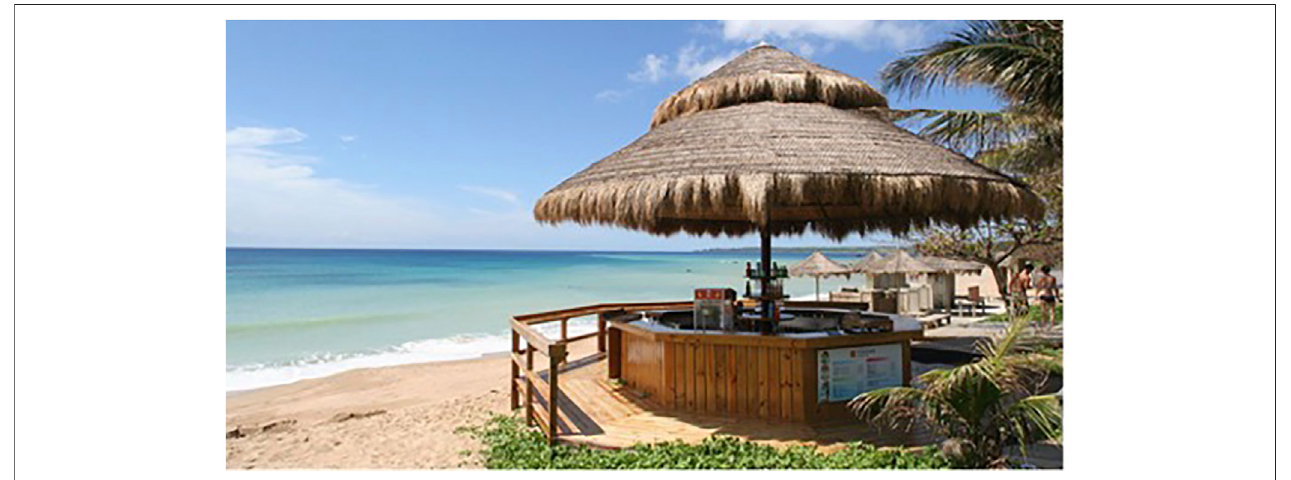
FIGURE 5 | A beach bar along Barbados ’ southwest